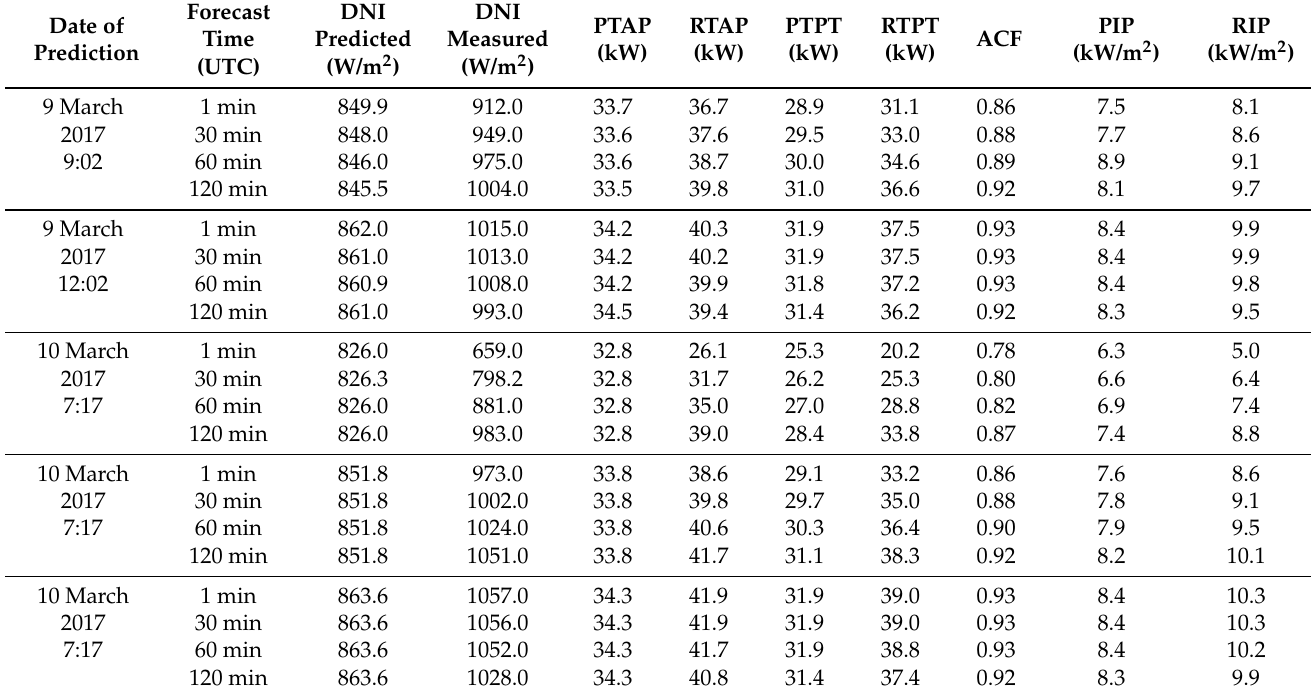
Table 4. Representation of the results obtained during the experiment performed in the solar field at the PSA, where the first column represents the date and hour of the prediction and the second column shows the time of the prediction; the other columns represent the numerical variables considered in the study. DNI predicted and DNI measured (in W/m 2 ), the predicted and real total available power (PTAP and RTAP, respectively) at ground, the predicted and real total power on target (PTPT and RTPT, respectively), the average cosine factor (ACF), the predicted irradiance peak (PIP) and the real irradiance peak (RIP).